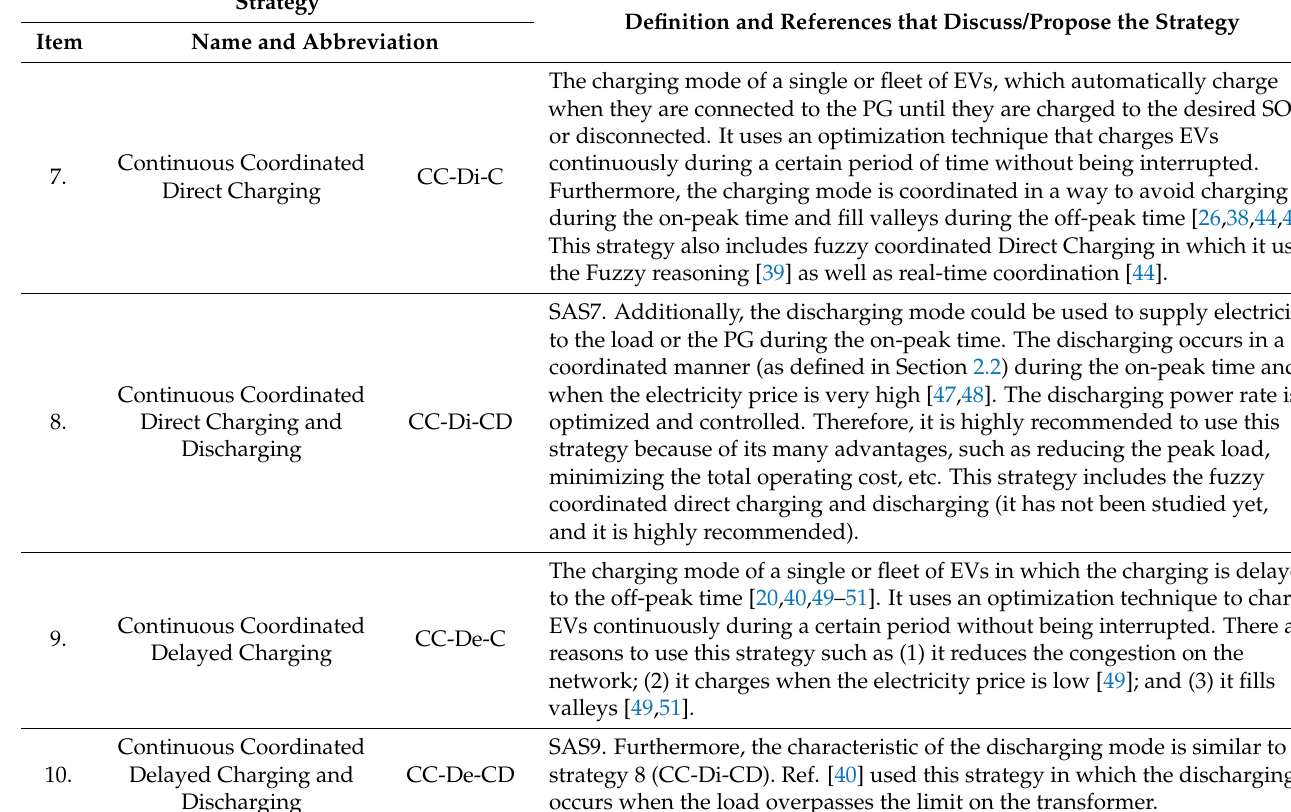
Table 2. Definitions of Continuous Coordinated Charging Strategies of EV.